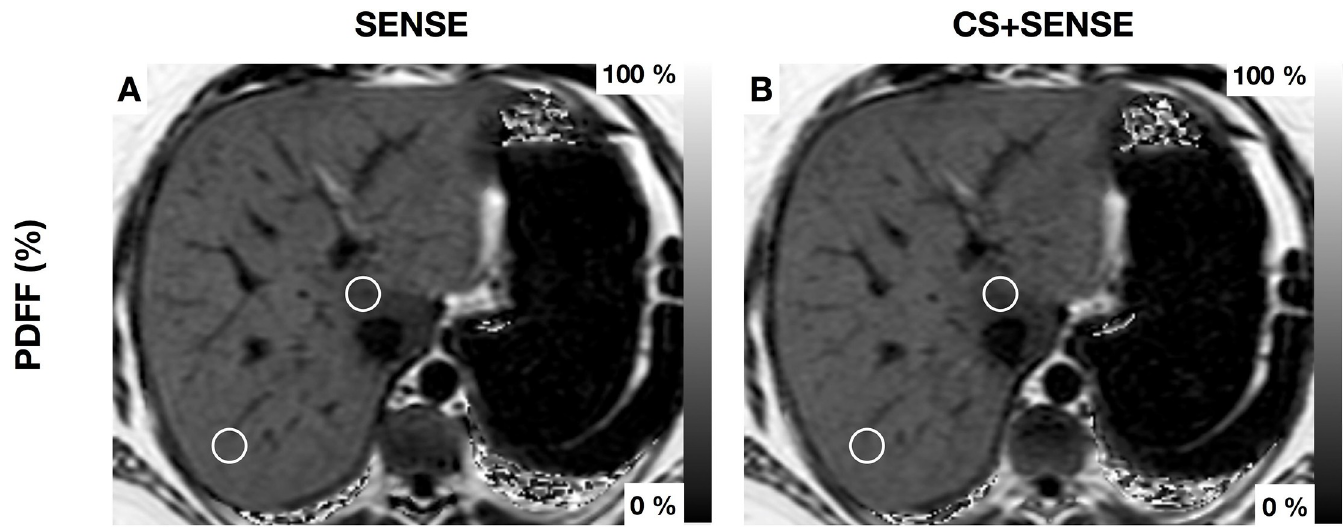
Fig 2. Patient with hepatic steatosis with focal fatty sparing of Segment I. Exemplary region of interest are drawn in Segments I and VII (1.5cm). PDFF Segment I: acquisition with SENSE 25.9 ± 3.8% (A); acquisition with CS+SENSE CS4 25.8 ± 4.5% (B) PDFF Segment VII: acquisition with SENSE 32.2 ± 2.0% (A); acquisition with CS +SENSE 33.2 ± 1.6%